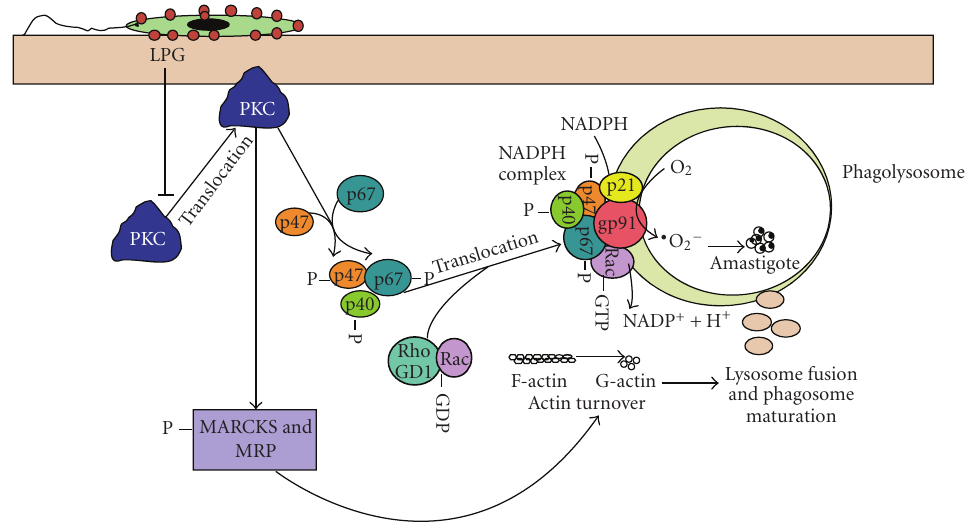
Figure 4: PKC regulation in Leishmania infected macrophages: LPG of Leishmania inhibits PKC activation and translocation to the membrane. PKC is responsible for phosphorylation of p47phox and p67phox components of NADPH oxidase which are subsequently translocated to phagosomal membrane to form NADPH oxidase complex, which is responsible for superoxide anion generation and hence parasite killing. Further PKC phosphorylates myristoylated alanine-rich C kinase substrate (MARCKS) and MARCKS-related protein (MRP) which are involved in actin turnover and finally in phagosomal maturation and lysosomal fusion resulting in parasite killing. As PKC activation is inhibited by Leishmania, this results in subsequent inhibition of all the above mentioned processes thereby favoring parasite